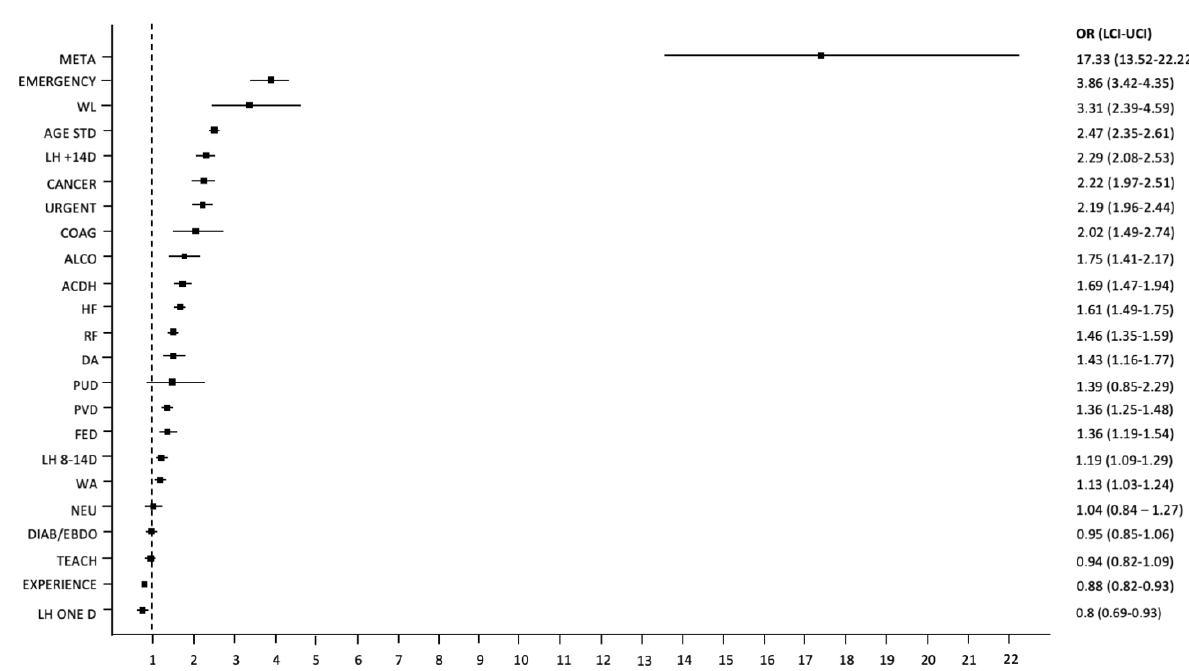
impact the risk of death during the 90 days following discharge. Abbreviations: ACDH—hospitalization due to Figure 4. Odds ratios with 95% confidence intervals (represented by bars) for the variables used in the model that may